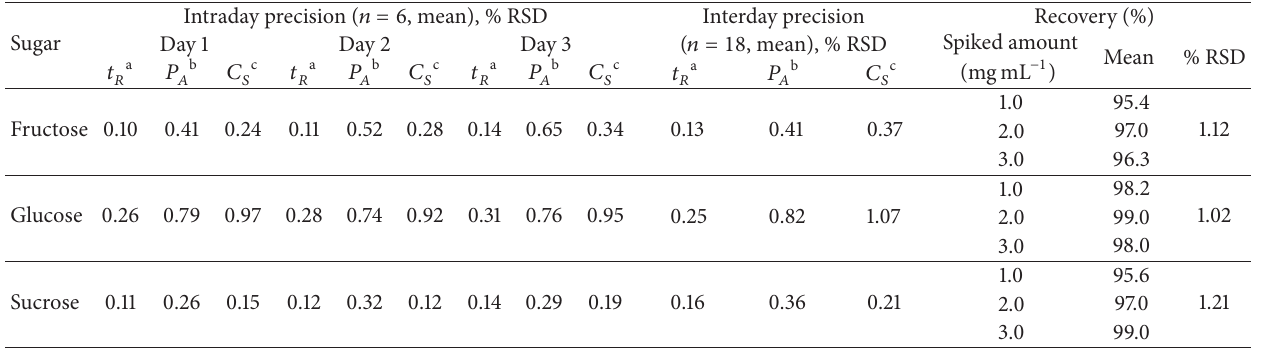
Table 3: Precision and recovery data for retention times, peak areas, and sugar